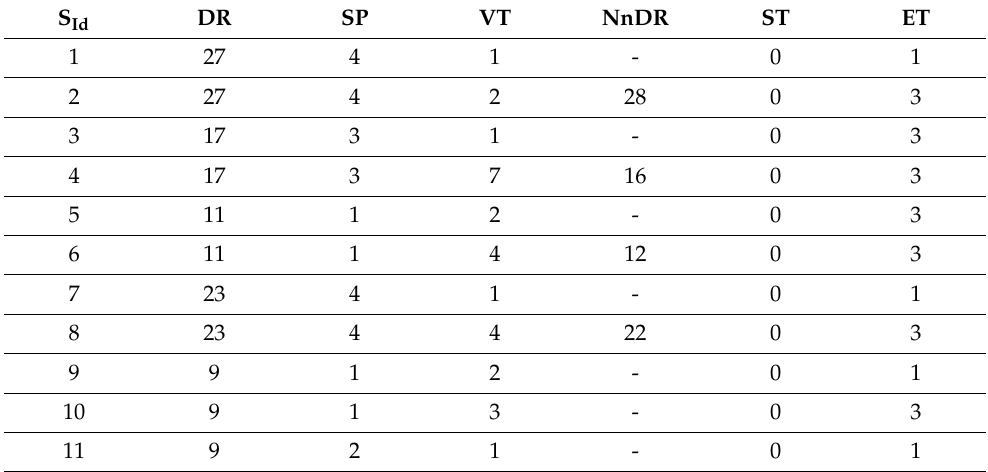
Table 6. Sample of distribution schedule generated by the dynamic distribution model with multi- priority, fuzzy travel distance and sliding window (Time Slot